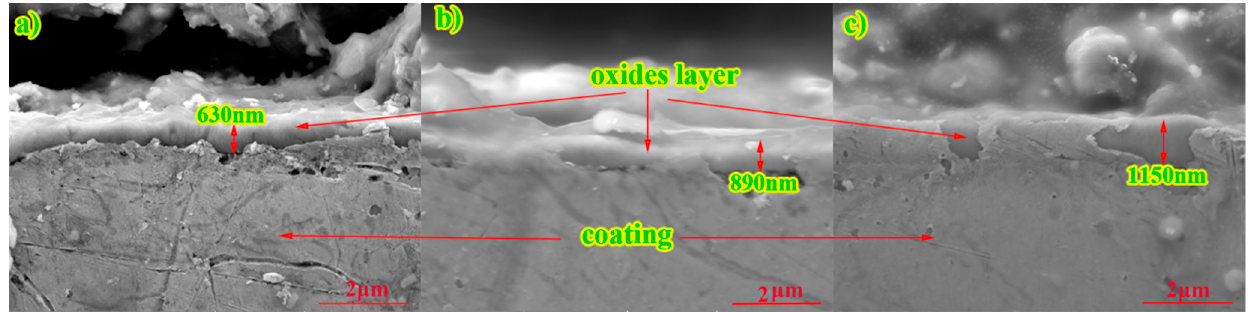
Figure 11. The cross-sectional images of oxides layer of CoMoCrSi coatings annealed for 3 h ( a ), 5 h ( b ), and 10 h ( c ).